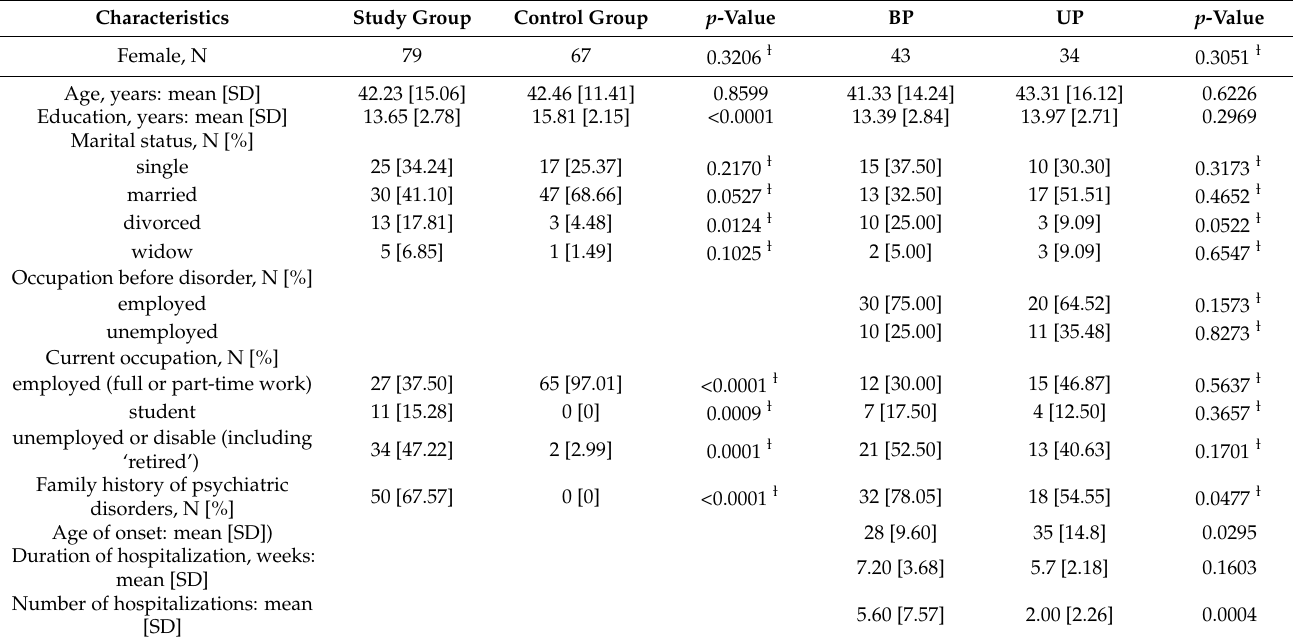
Table 1. Sociodemographic